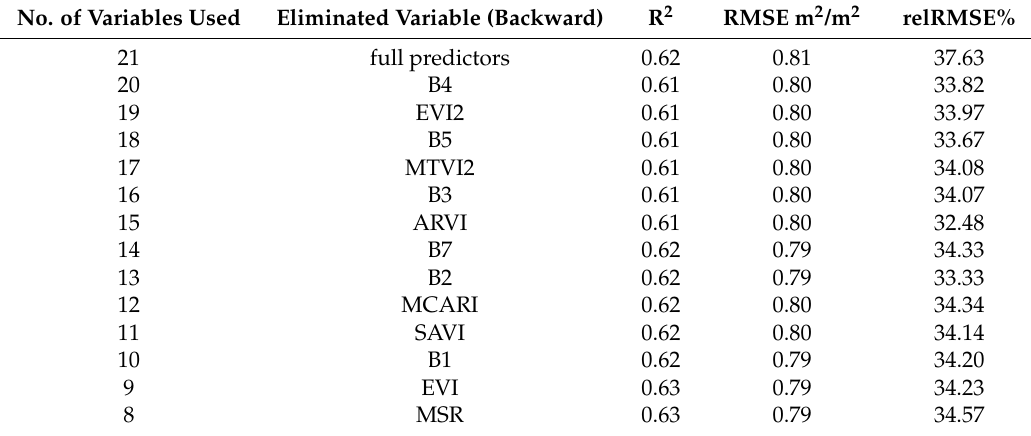
Table 4. RF model performance by backward elimination of variables for dry season data. No. of Variables